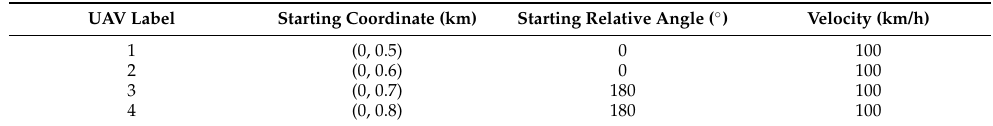
Table 2. UAV information.